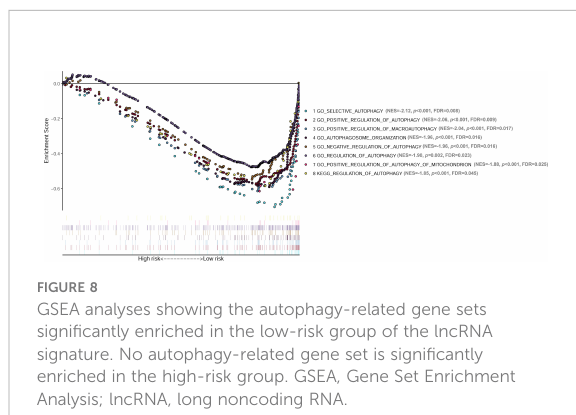
FIGURE 8 GSEA analyses showing the autophagy-related gene sets signi fi cantly enriched in the low-risk group of the lncRNA signature. No autophagy-related gene set is signi fi cantly enriched in the high-risk group. GSEA, Gene Set Enrichment Analysis; lncRNA, long noncoding